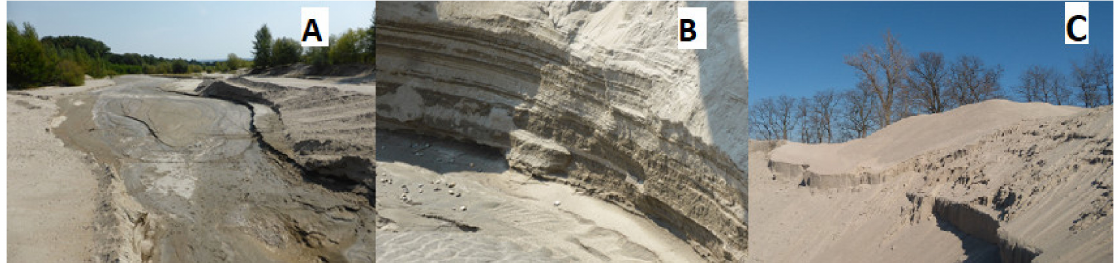
Figure A1. ( A ) Place of the pulp dump into settlement tank which creates the periodic and braided river. ( B ) Characteristic laminated sand sediments deposited on the settling tank. ( C ) Sand heaps